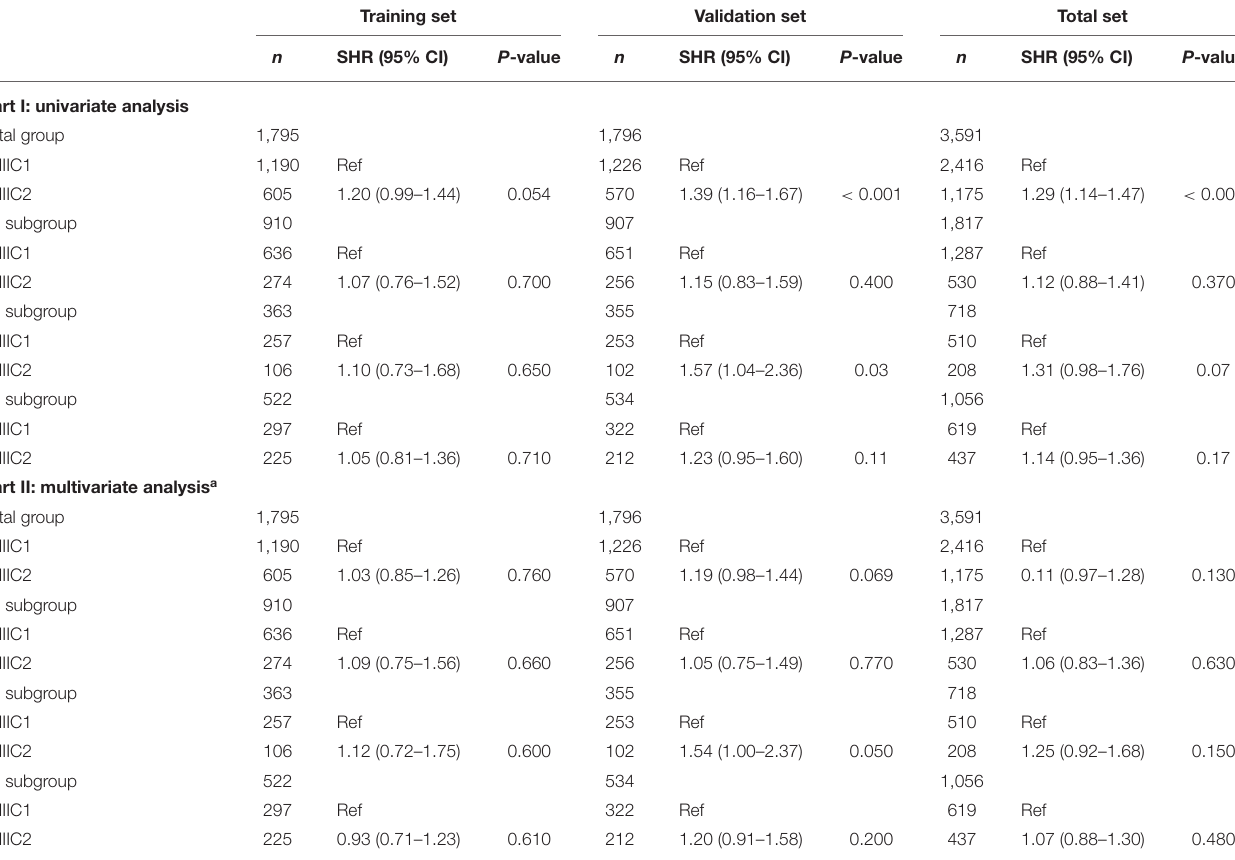
FIGO, Fédération Internationale de Gynécologie et d’Obstétrique; SHR, subdistribution hazard ratio. a The multivariate analysis was adjusted for age, race, marital status, histologic grade, American Joint Committee on Cancer T stage, and treatment modalities (surgery, chemotherapy, and